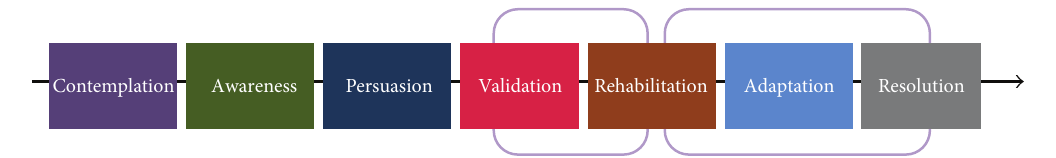
Figure 4: Main phases of communication partners’ journey through their partner’s hearing impairment (various stages are not drawn to any scale in regard to duration, and time spent in each phase may vary between